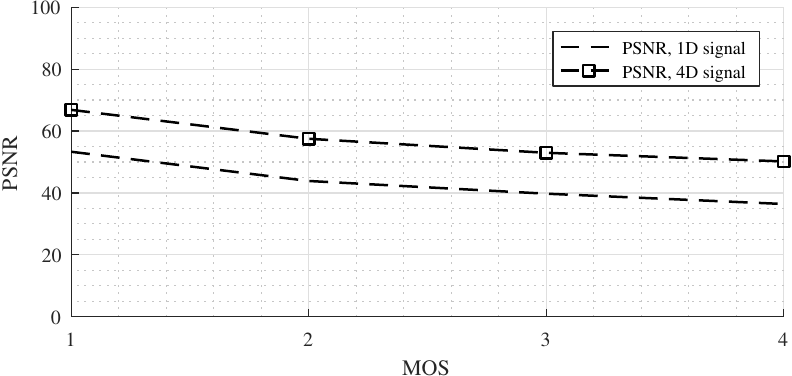
Figure 8. Peak signal-to-noise ratio (PSNR) for different multiples of overlap size (MOSs) with Non-linear 6 1D and 4D